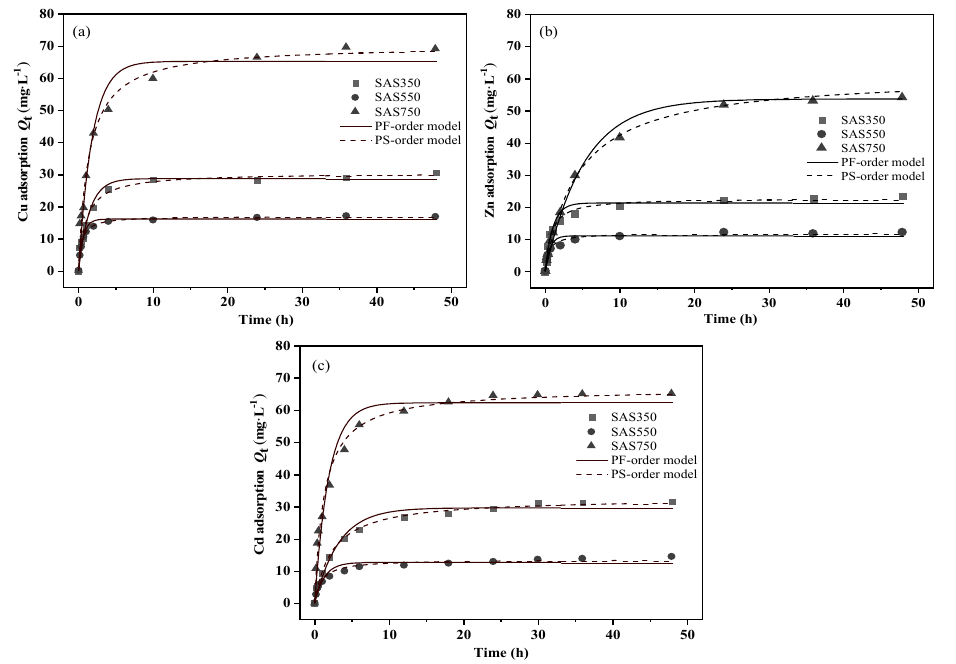
Figure 3. Kinetics of sorption of Cu(II) ( a ), Zn(II) ( b ), and Cd(II) ( c ) on biochars at 350, 550, and 750 °C.